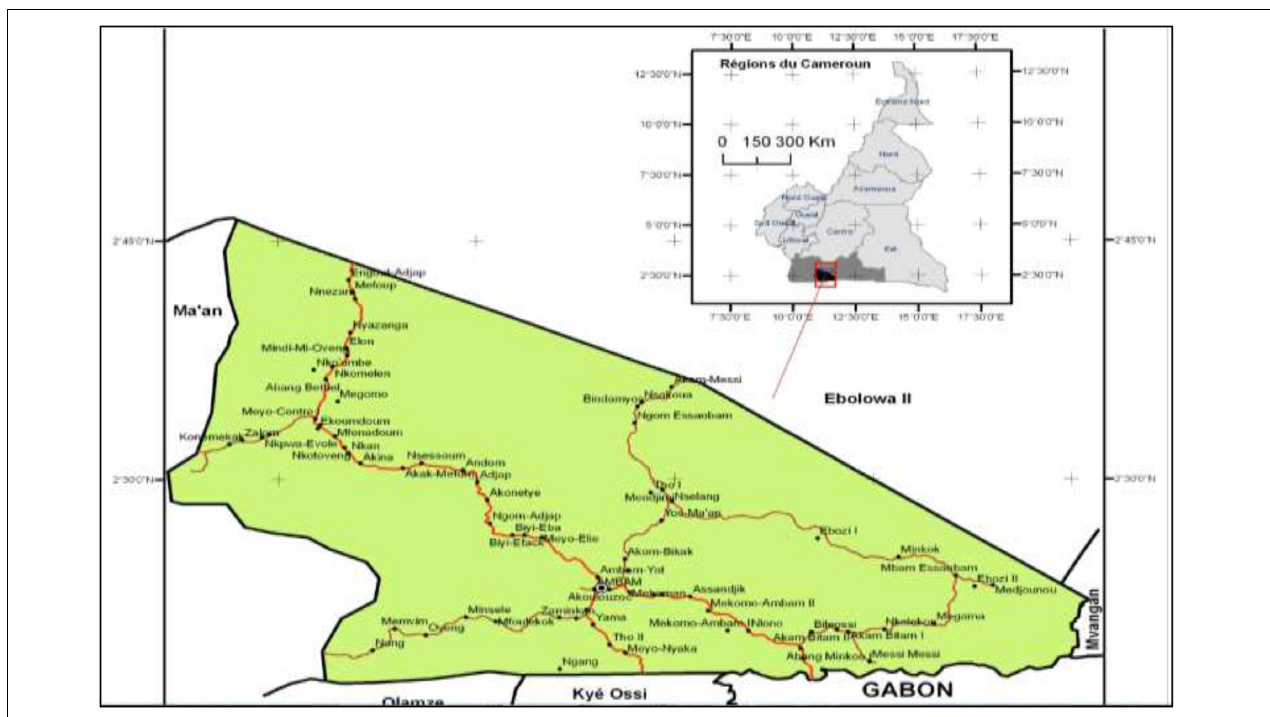
FIGURE 1 | The map of the location of Ambam.